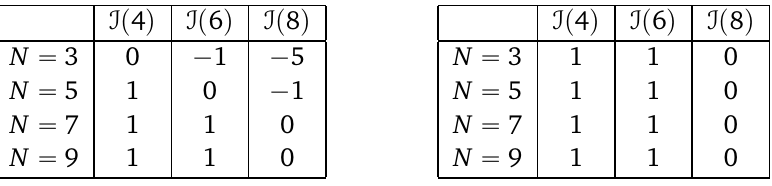
Table 1: The first few indices for the O p N q sigma model SO p N q . On the left are SO p N ´ 1 q indices without imposing any discrete symmetry, and on the right are indices when we impose the charge conjugation symmetry. We take N to be odd for simplicity. The case with N “ 3 is the same as the (cid:67)(cid:80) 1 case considered in Section 4.1. Thus our analysis confirms the presence of a spin-4 conserved current and we predicts a new spin-6 conserved current at the quantum